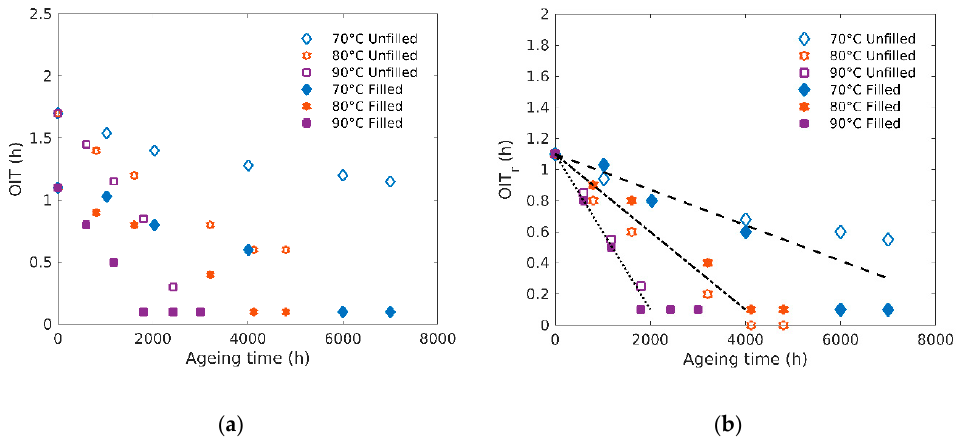
Figure 1. ( a ) Oxidation induction time (OIT) and ( b ) relative OIT (OIT r ) evolution as a function of ageing